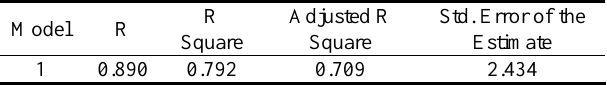
Tab.2. The determinant coefficient of regression model 1